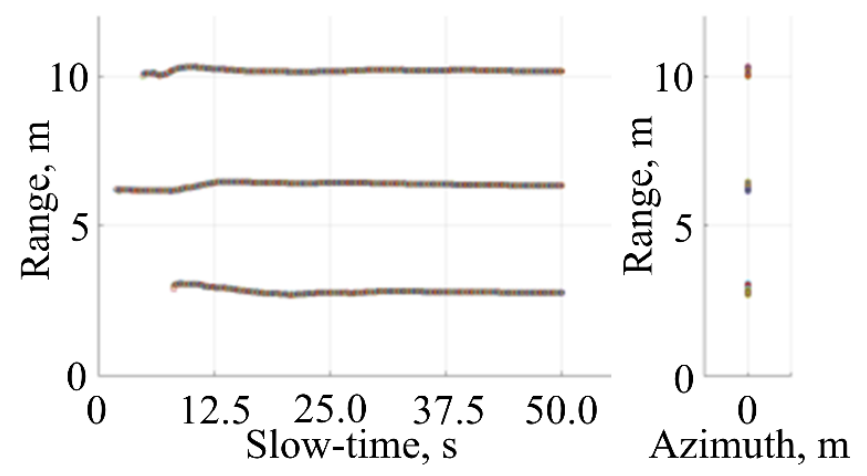
Figure 8. Experimental detection and classification result for stationary operating mode.